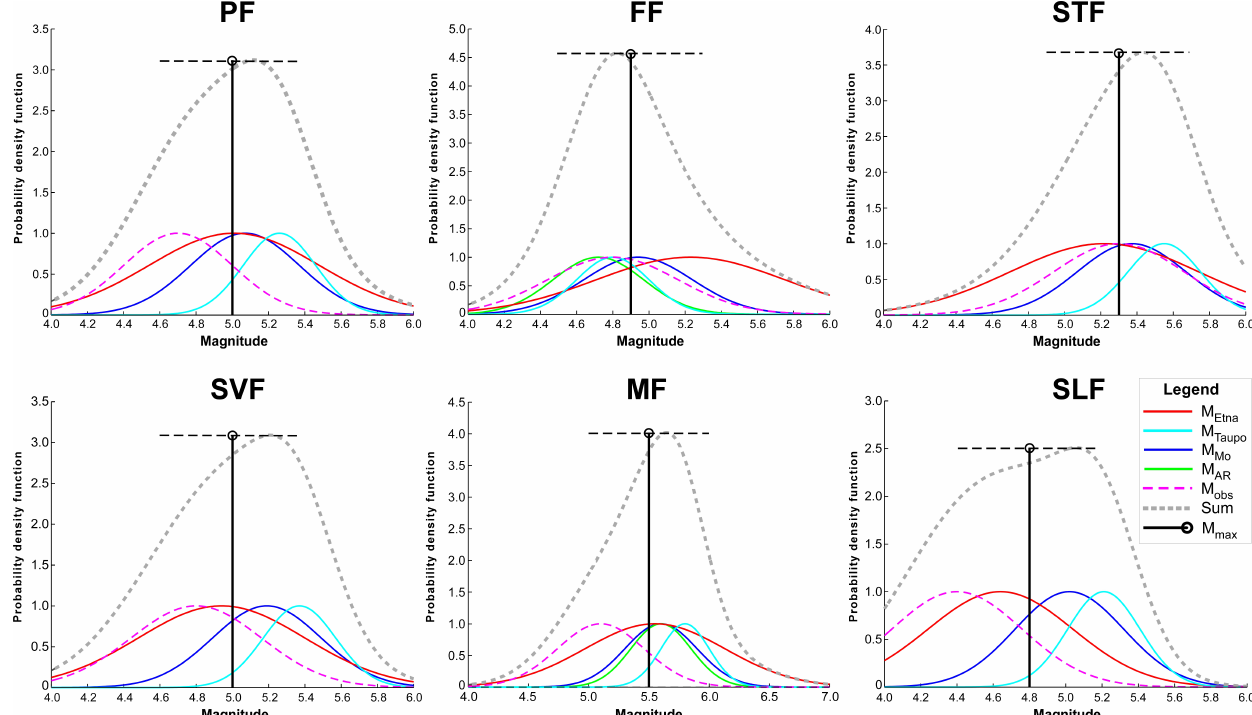
Figure 11. Maximum magnitudes ( M max ) estimated by the FiSH code for the studied faults. Abbreviations: M Etna − M Taupo is the magnitude from earthquake scaling relationships for Etna and Taupo; M Mo is the scalar seismic moment magnitude; M AR is the magnitude from aspect ratio relationships; M obs is the maximum observed magnitude. Uncertainties are represented by probability curves (see text for